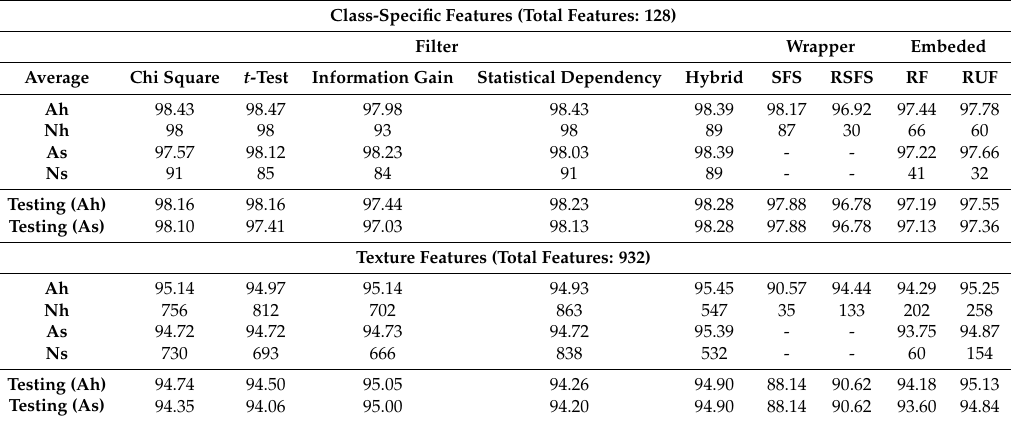
Table 8. Comparison of methods: Experimental protocol